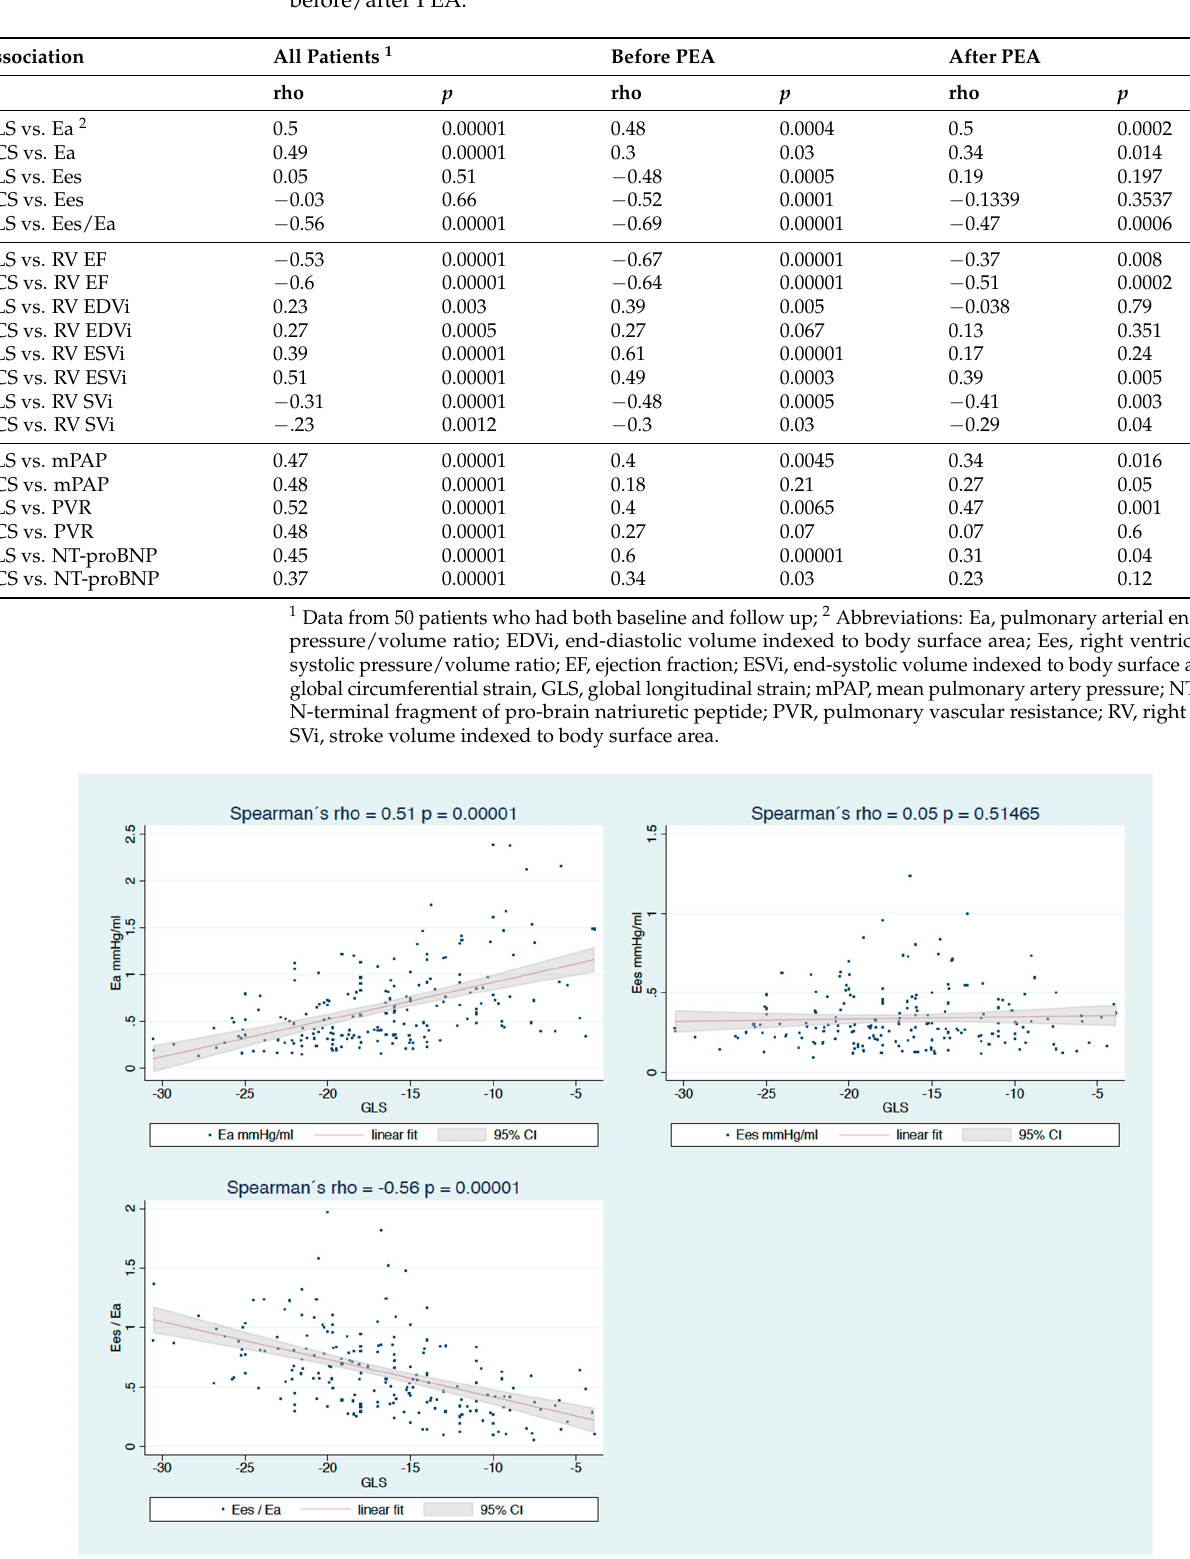
Figure 3. Correlations of GLS with afterload Ea (pulmonary arterial elastance), contractility Ees (end-systolic elastance of the RV), and ventriculoarterial coupling Ees/Ea.